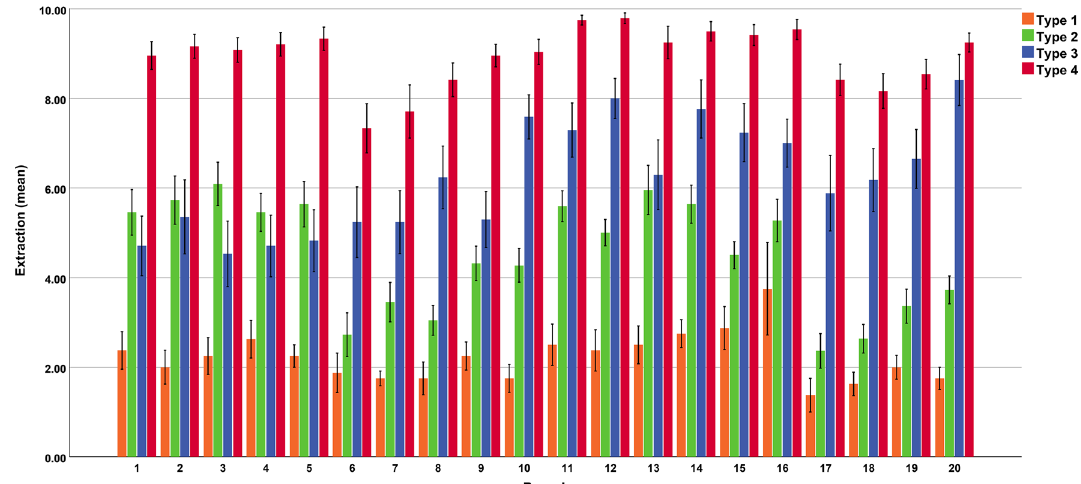
Figure 2. Distinct behavioural types in the sequential resource dilemma. Data-driven and model-free cluster analysis across all 20 rounds of the sequential resource dilemma identified four distinct behavioural types. Type 1 consisted of 8 participants, Type 2 of 22 participants, Type 3 of 17 participants and Type 4 of 24 participants. Note that we excluded Type 1 from further analyses because this type consisted of only 8 participants and showed a very sustainable behaviour across all rounds of the paradigm (before and after the warnings), leaving (almost) no margin and no necessity for warning reactions. Error bars depict standard errors of the